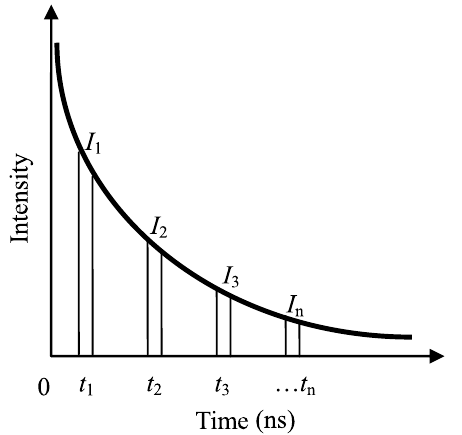
Fig. 4. Time domain FLIM method. 28